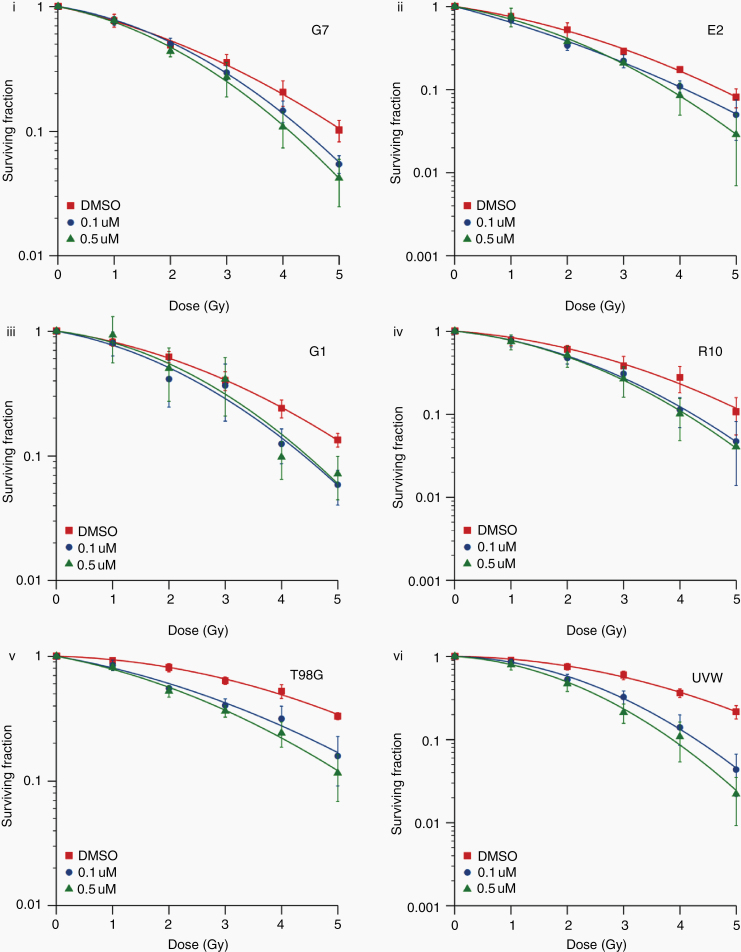
In vitro validation of clinically deliverable olaparib concentrations. The impact of 2 different doses of olaparib on radiosensitivity of 4 primary (i–iv) and 2 established (v–vi) GBM cell lines was measured by clonogenic survival assay. Twenty-four hours after plating, cells were exposed to olaparib or DMSO control then irradiated (1–5 Gy) or sham-irradiated one hour later. Visible colonies containing at least 50 cells were counted 14–21 days after treatment and surviving fraction calculated. The linear quadratic model was fitted using maximum likelihood estimation and integrated to determine the mean inactivation dose (MID) for each experimental condition.